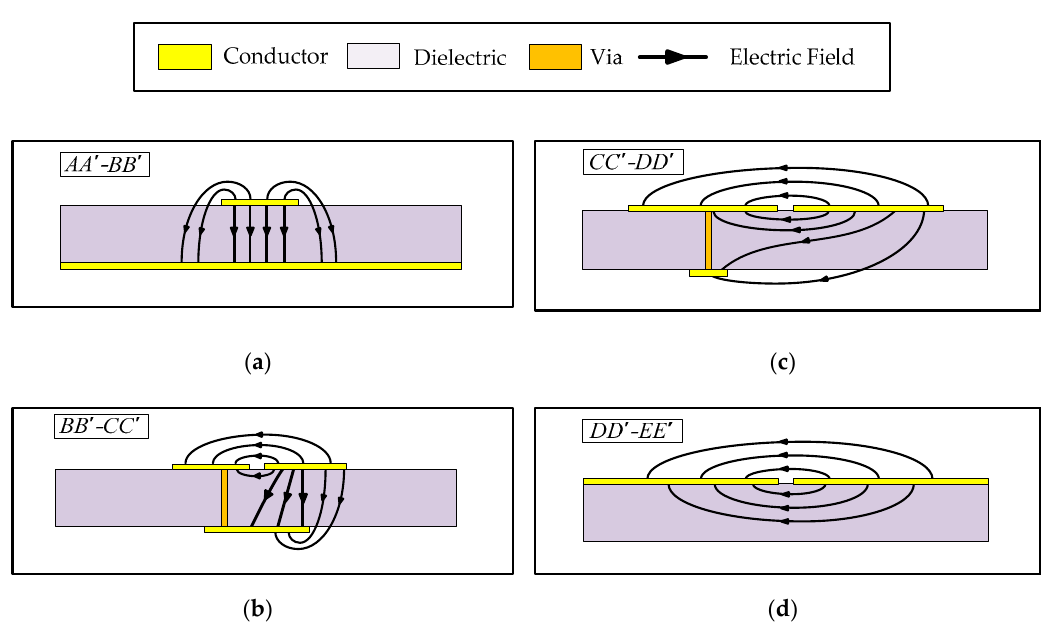
Figure 2. Electric field distribution at each section of the proposed transition: ( a ) AA ′ - BB ′ ; ( b ) BB ′ - CC ′ ; ( c ) CC ′ - DD ′ ; ( d ) DD ′ - EE ′ .